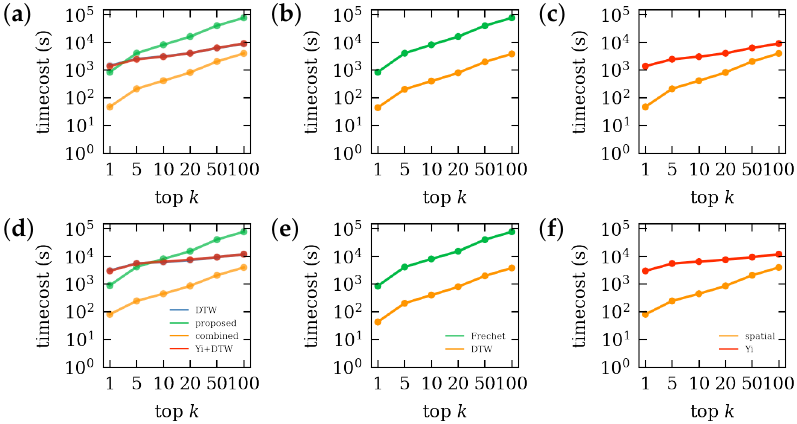
Figure 7. Computational cost of similarity search on time series in different steps. ( a – c ) Strictly similar time series search; ( d – f ) Search time series with the similar trend; ( a , d ) The overall computational time; ( b , e ) The computational time of the distance calculation step; ( c , f ) The computational time of the pruning